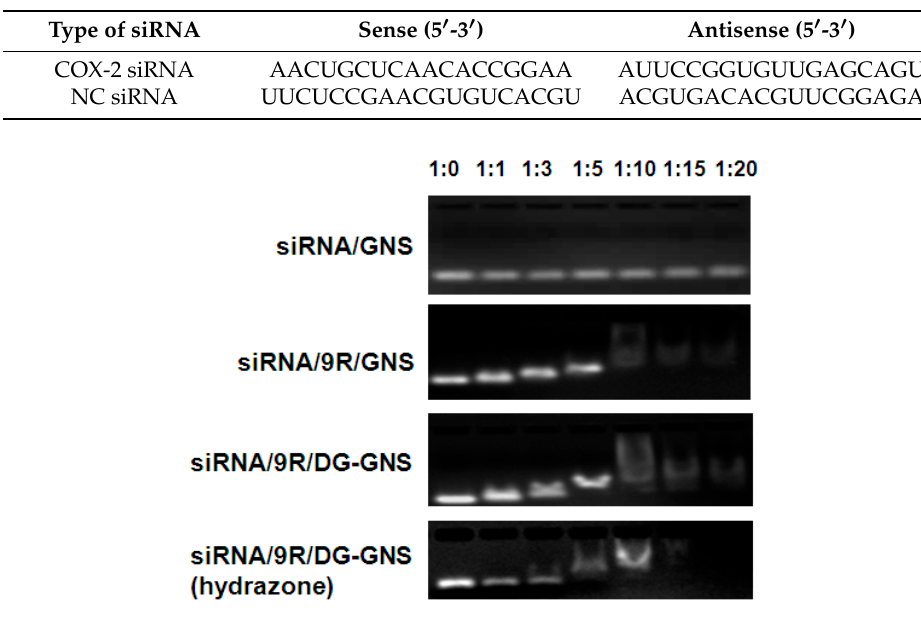
Figure 3. The agarose gel electrophoresis of GNS, 9R-GNS, 9R/DG-GNS, 9R/DG-GNS (hydrazone) and siRNA mixture with different ratios (1:0, 1:1, 1:5, 1:10, 1:15 and